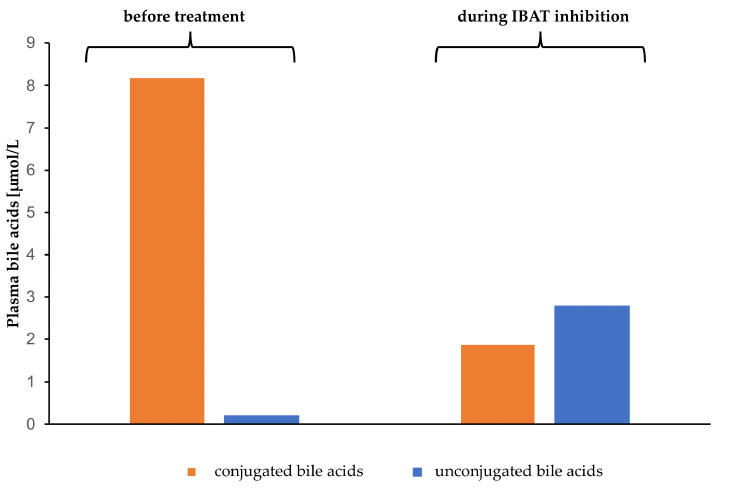
Figure 4. Conjugated and unconjugated plasma bile acids before and during treatment with IBAT inhibitors. IBAT, ileal bile acid transporter